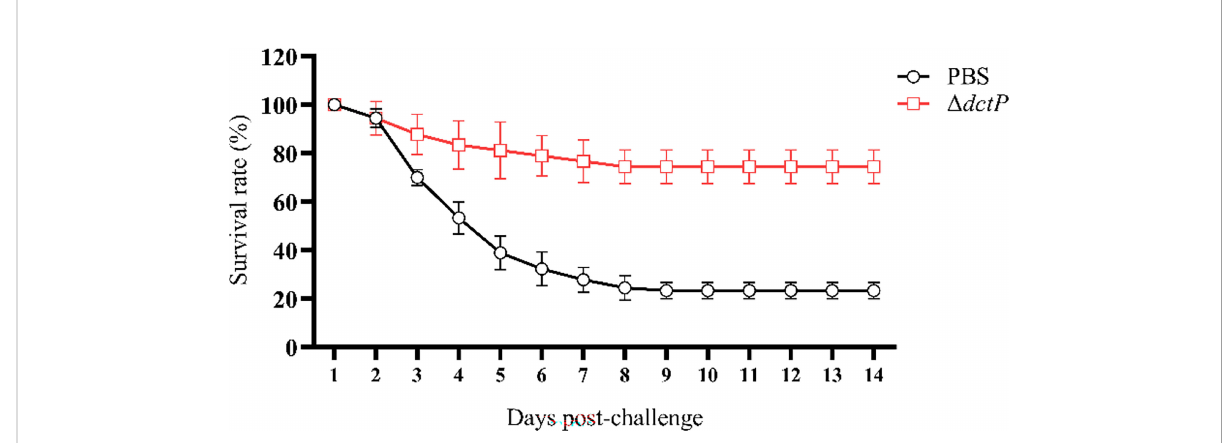
FIGURE 2 Survival rate of vaccinated groupers challenged with V. alginolyticus for 14 days. Values are means ± SD (n = 3).